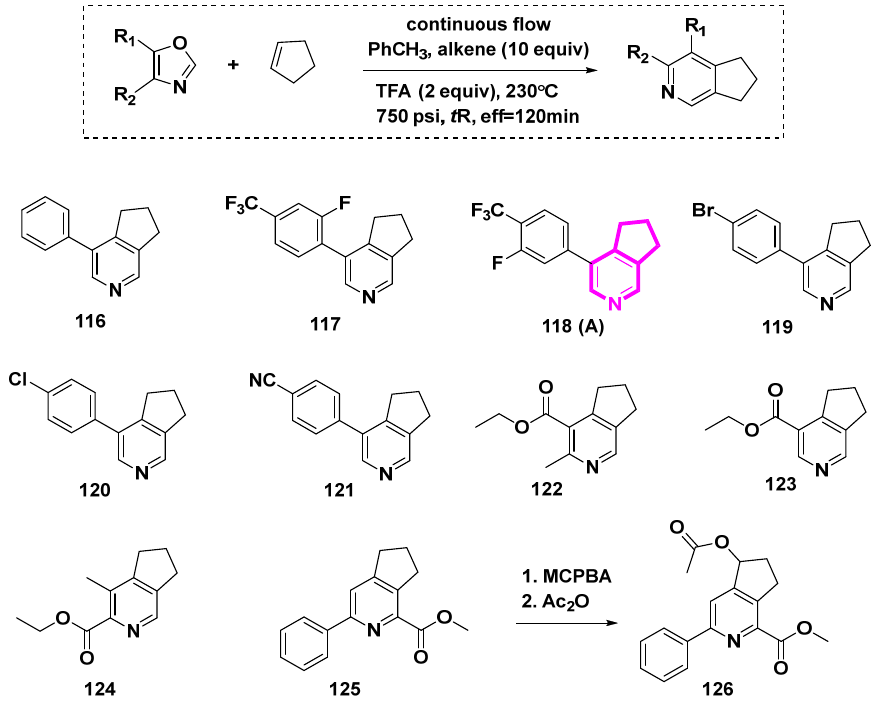
Scheme 13. The Kondrat’eva Reaction in Flow: synthesis of annulated